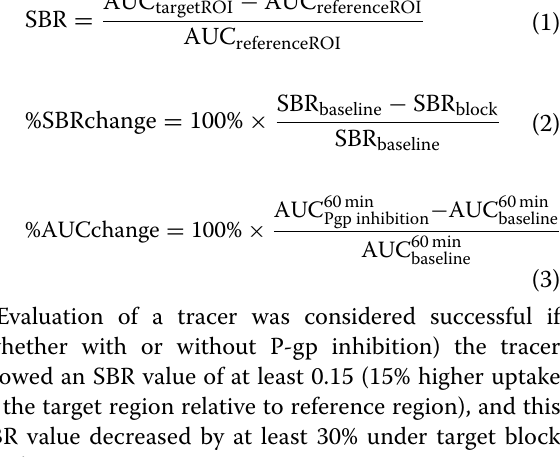
file 1: Table S1; numbers of rats scanned per experimen- tal condition are shown in Additional